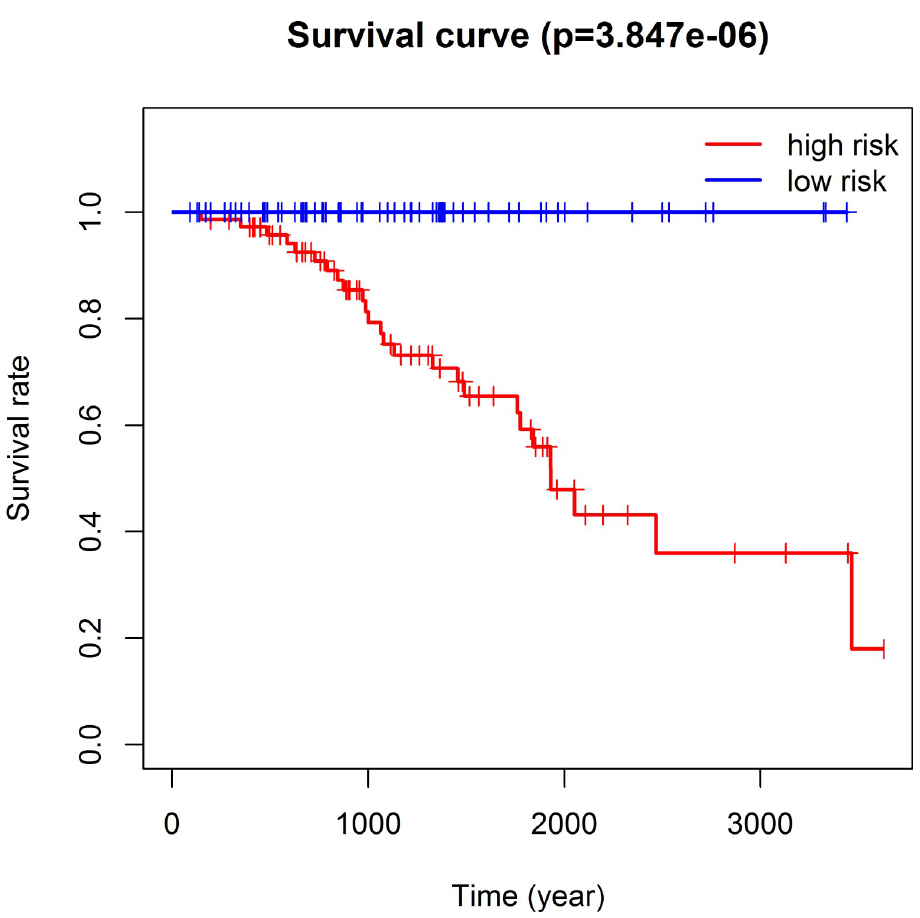
Fig 13. ICGC Kaplan-Meier survival analysis of PCa patients with Gleason score > 7.